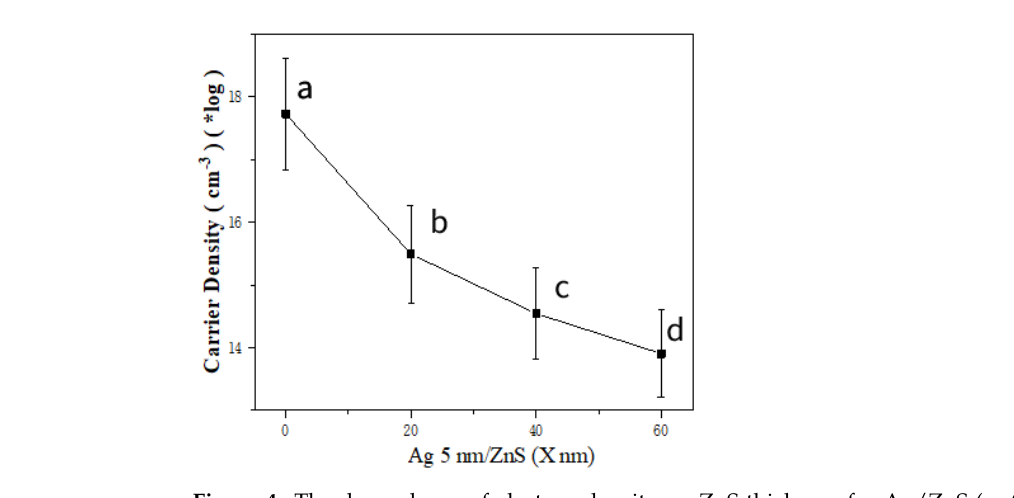
Figure 4. The dependence of electron density on ZnS thickness for Ag/ZnS (a. 0 min; b. 5 min; c. 10 min; d. 15 min) films on PS beads.